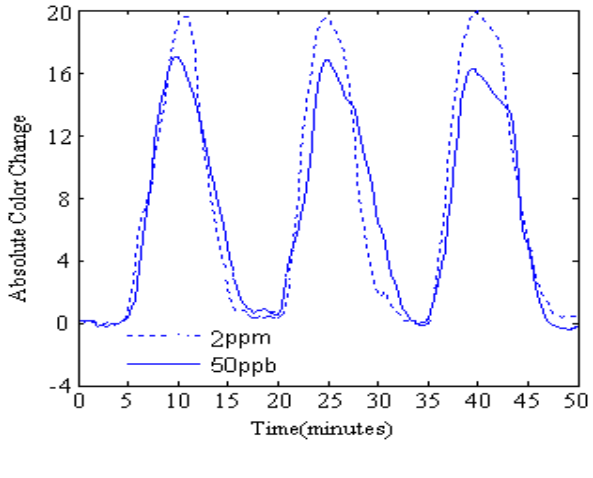
Figure 7. Repeating cycling of TMA exposure of CSA from N 50 ppb (solid line), respectively. The color change value is the sum of the absolute color changes in all the 18 color channels on the